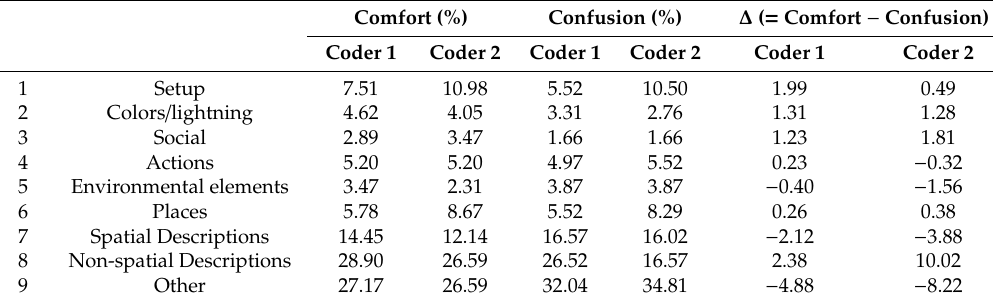
Table 3. Proportions of the categories of the most frequent